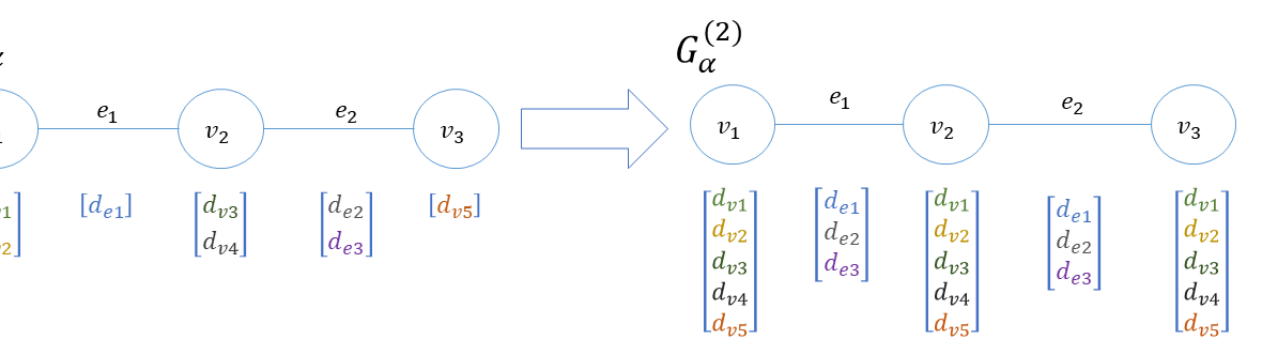
Figure 2. Example of frequent slicing and an application of reachability. G α is the starting network in a non-directed format. ( 2 ) G α is the set of attributes reachable from G α